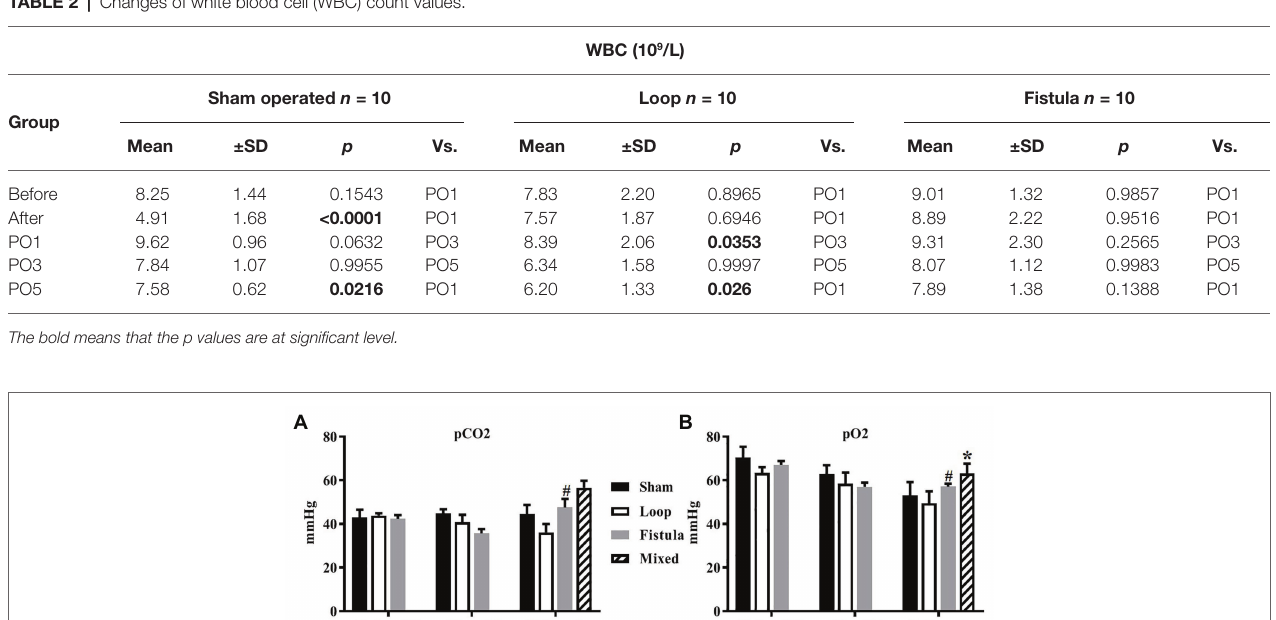
TABLE 2 | Changes of white blood cell (WBC) count values.